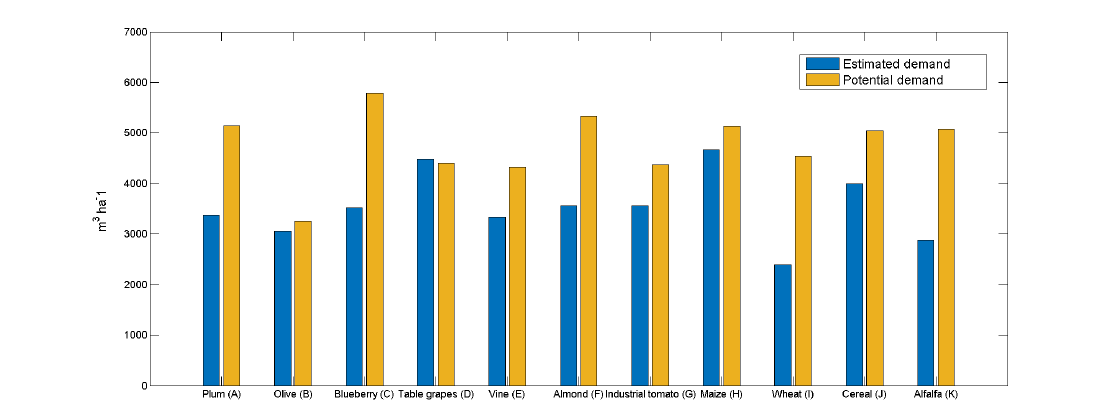
Figure 9. Estimated and potential seasonal water demand for orchards and annual crops representative of the study